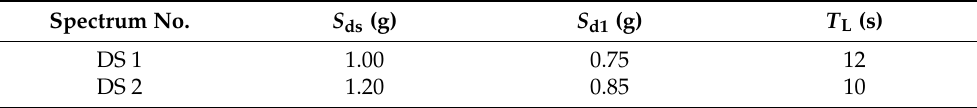
Table 2. Design parameters of the ASCE design spectra.